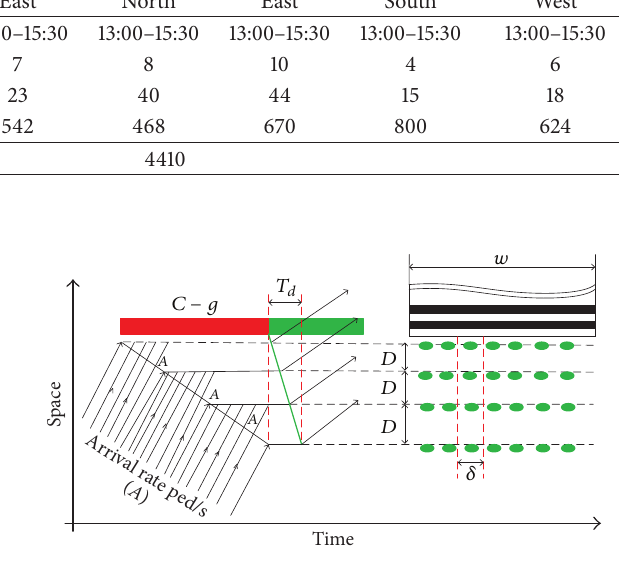
Figure 2: Pedestrian waiting and discharge